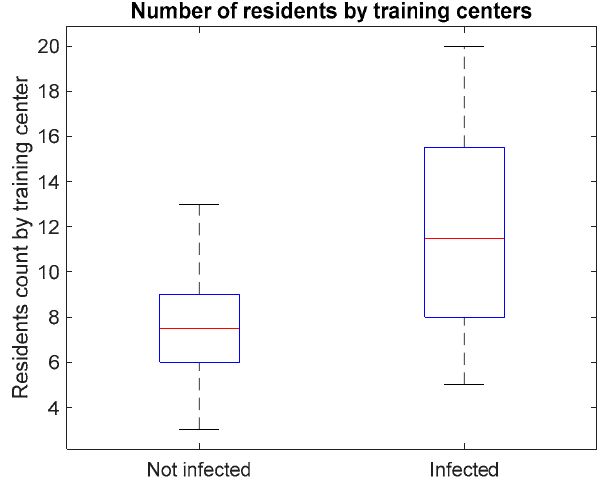
Figure 4. Distribution of respondents considering their count on training center.